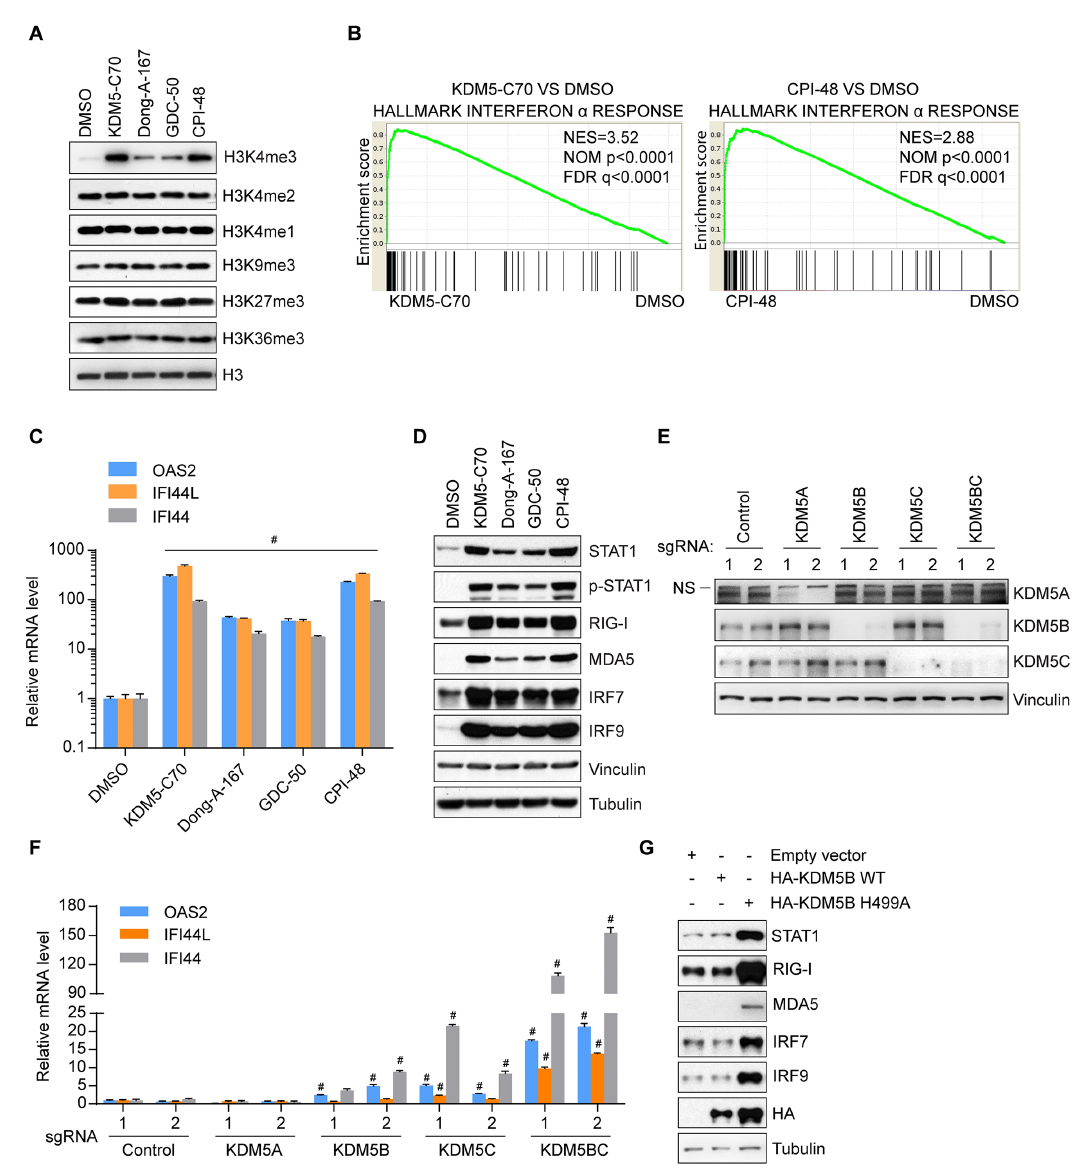
PLOS Biology | https://doi.org/10.1371/journal.pbio.2006134 August 6, 2018 4 /